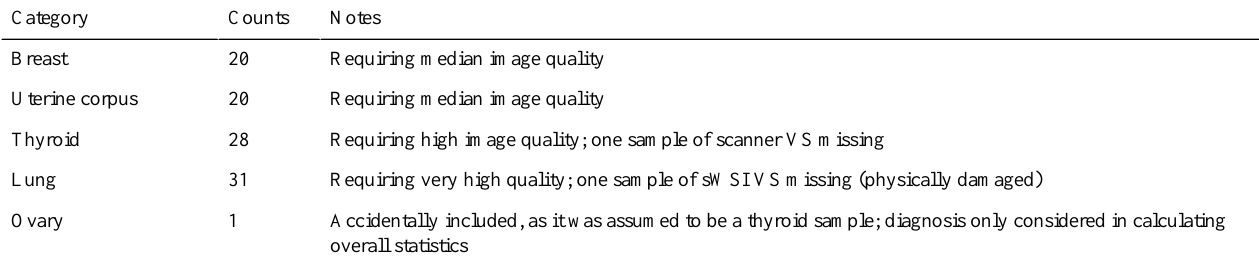
Table 3. Sample categories, counts, and